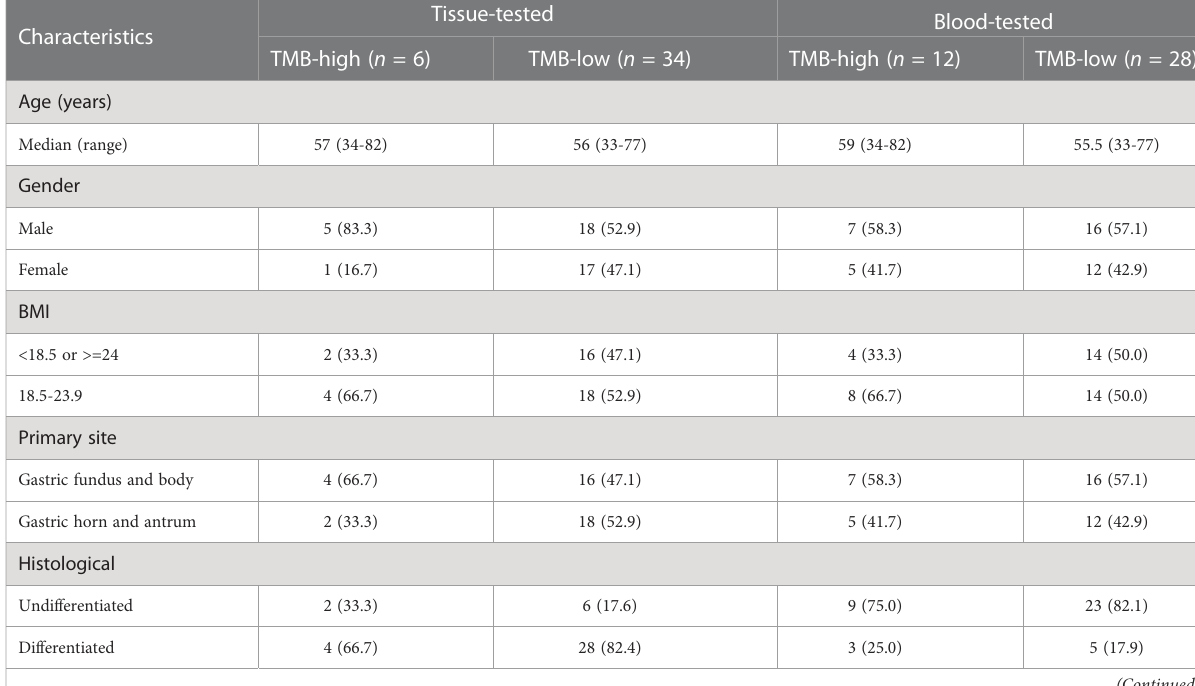
Characteristics